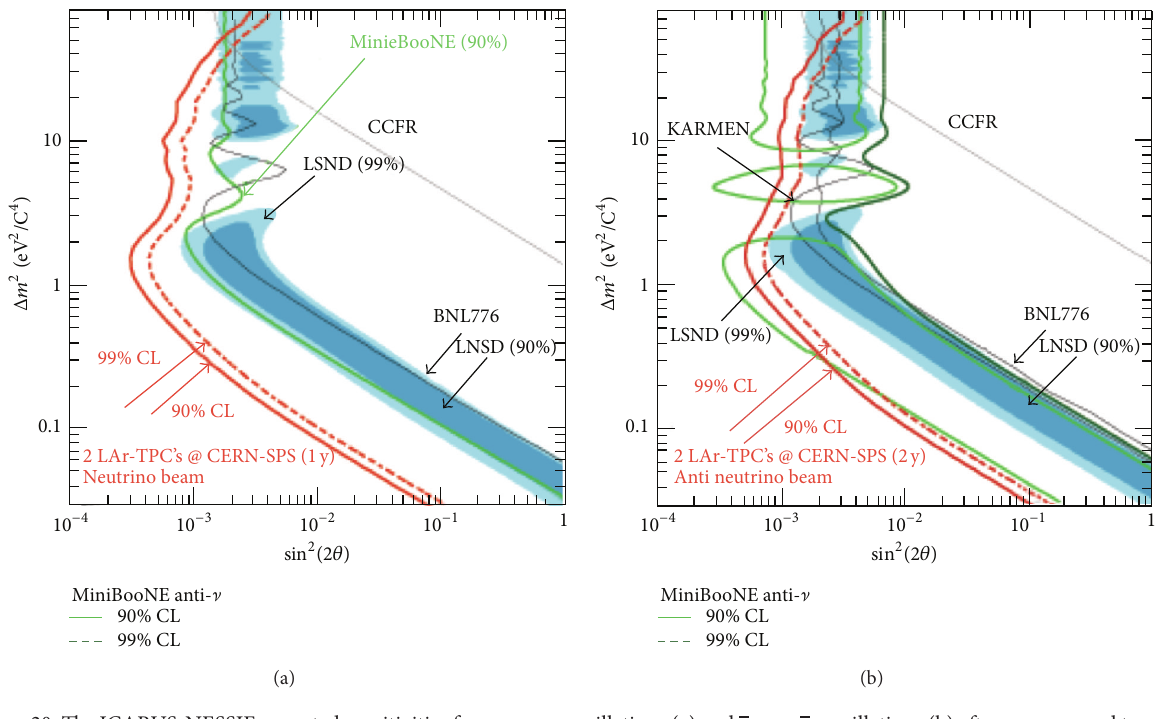
Figure 20: The ICARUS-NESSIE expected sensitivities for ] 𝜇 → ] 𝑒 oscillations (a) and ] 𝜇 → ] 𝑒 oscillations (b) after one year and two years of data taking, respectively (from [32]).